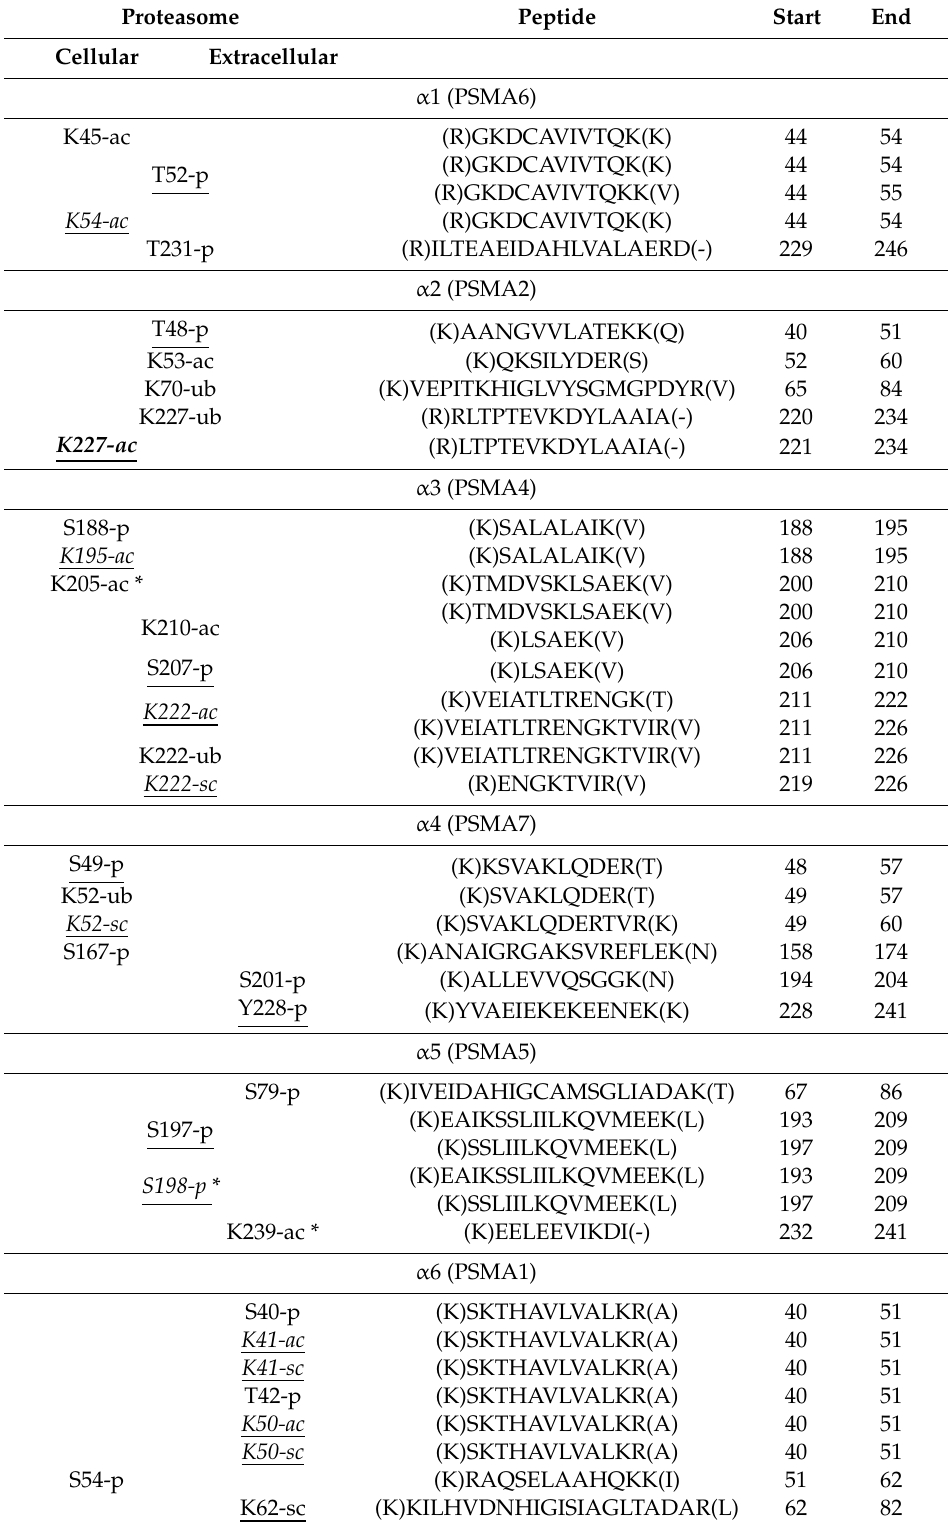
Table 1. Potential modifications of cellular and extracellular proteasomes identified by MALDI FT-ICR